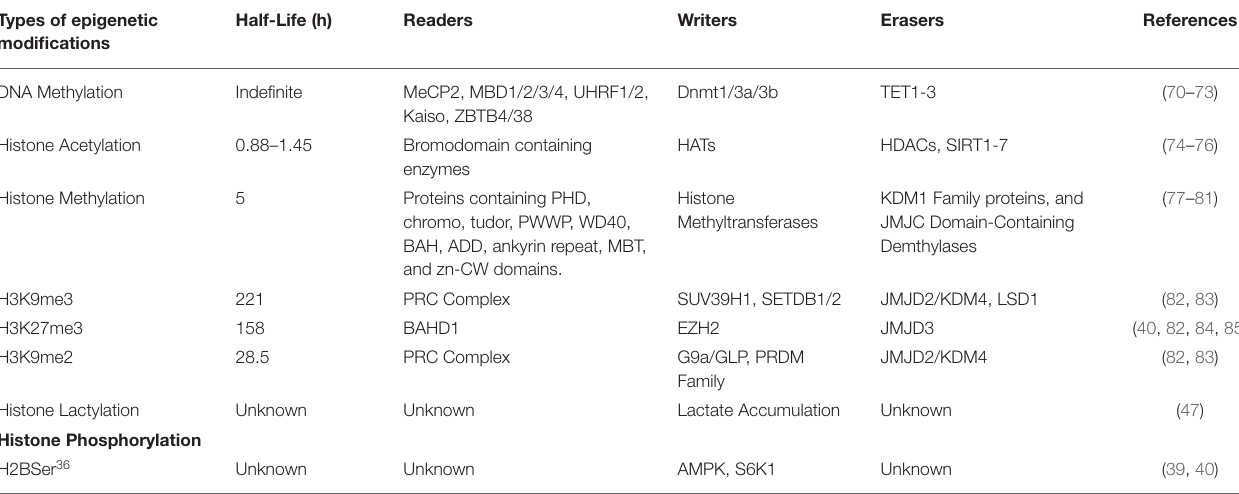
TABLE 1 | Represenation of the types of epigenetic modifications that can be induced by environmental sensing, and the specific modifications